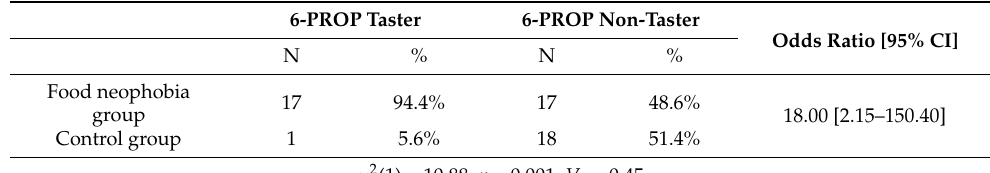
Table 4. The relationship between the occurrence of food neophobia and hypersensitivity to bitter taste